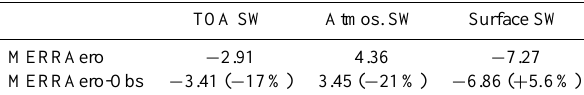
Table 2. Global JJA 2007 clear-sky aerosol direct radiative effect (Wm − 2 ) for MERRAero baseline and MERRAero updated with the observation-based dust optical properties.